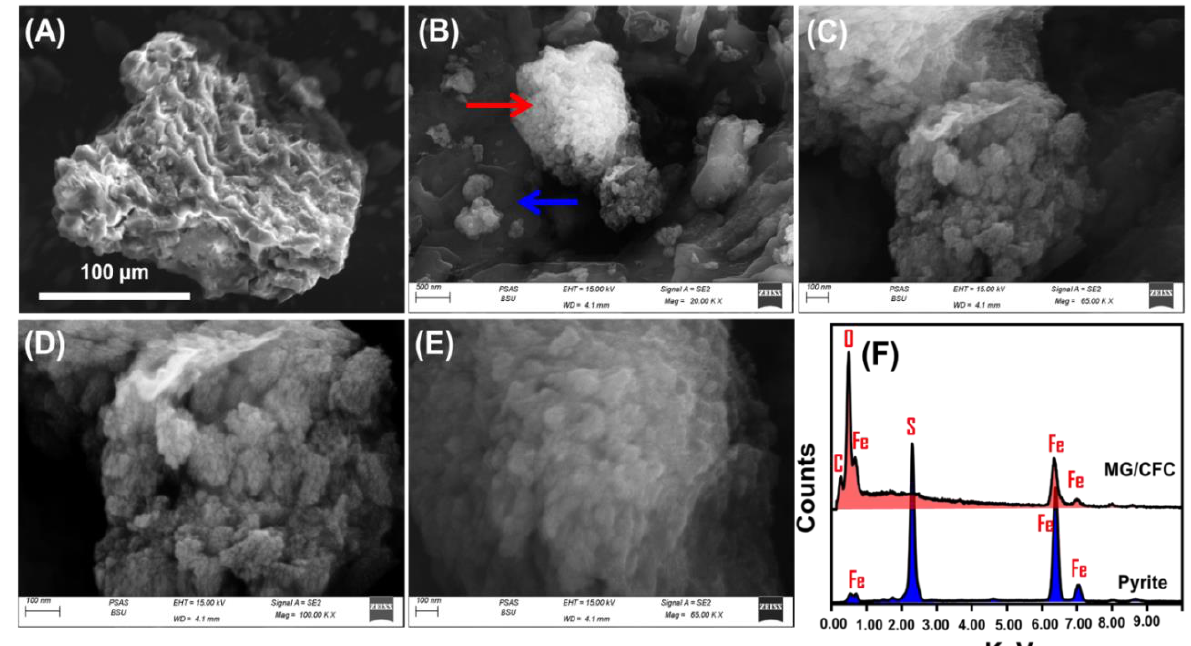
Figure 2. SEM images of the carbonized coffee grains ( A ), the synthetic green magnetite nano particles over the surface of carbonized coffee ( B – E ), and the EDX spectra of pyrite and the prepared MG/CFC composite ( F ).